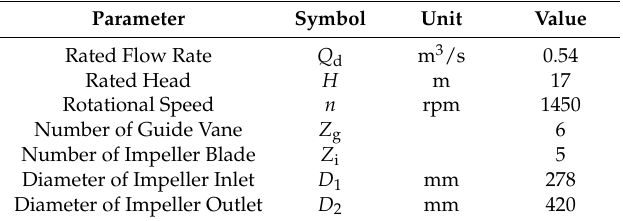
Table 1. Energy performances of pumps with different tip clearances.